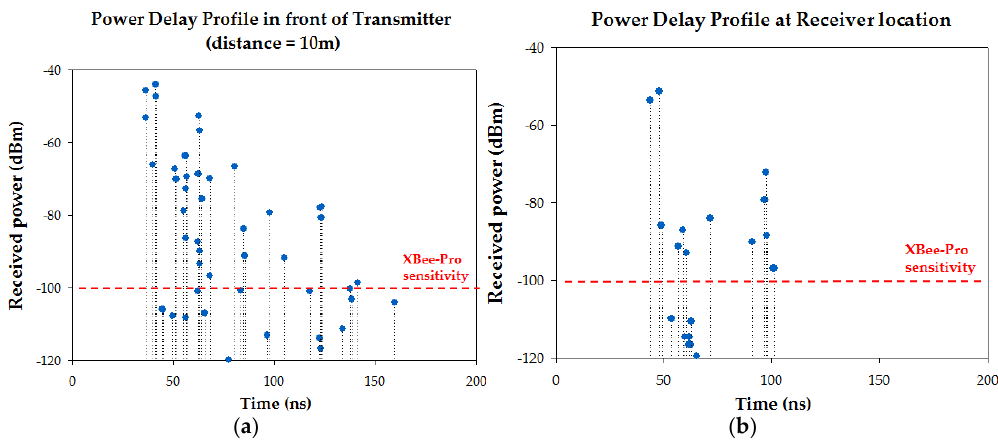
Figure 12. Power delay profiles at two different positions: ( a ) In front of the transmitter on the judoka’s chest at a distance of 10 m; ( b ) At the receiver location.